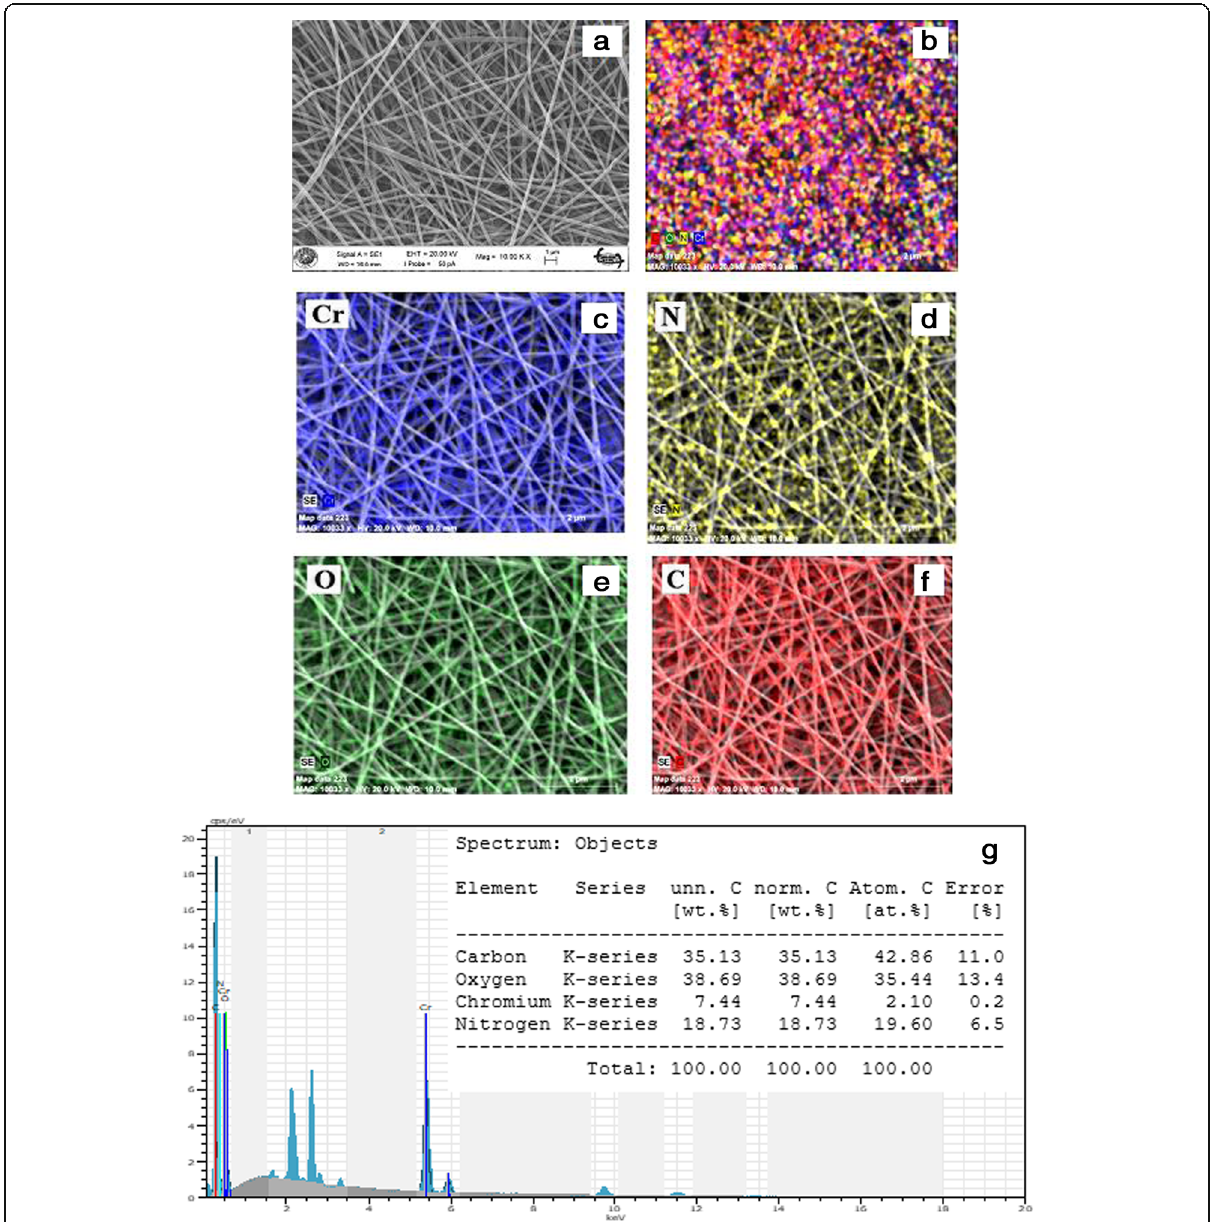
Fig. 6 SEM image of N6,6/GO nanofibers after Cr (VI) adsorption ( a ), EDX elemental maps ( b – f ), and EDX spectrum ( g